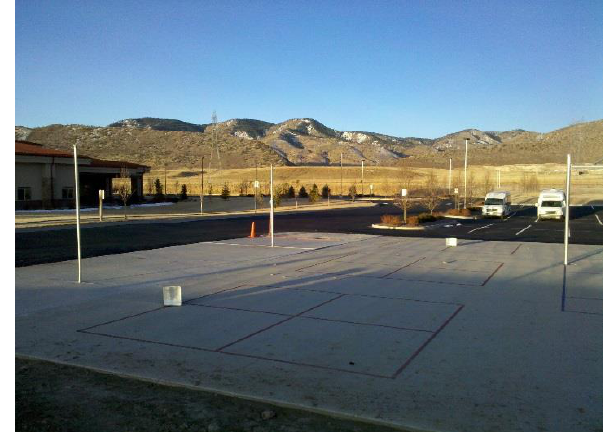
Figure 12. Small reflector (0.3 m by 0.3 m by 0.4